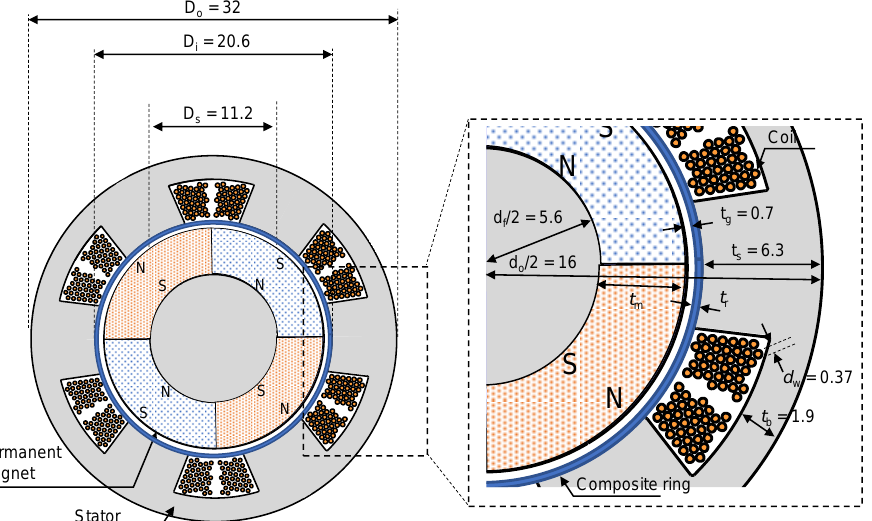
Table 2. Material specifications.